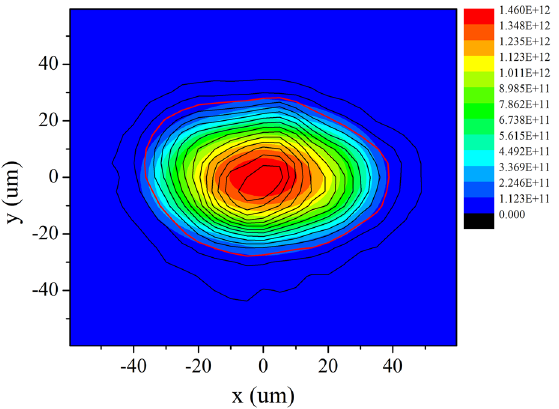
Figure 9. (Color online) Self emission distributions of DD fuel hotspot only. The contour lines are extracted from the experimental results of Fig.